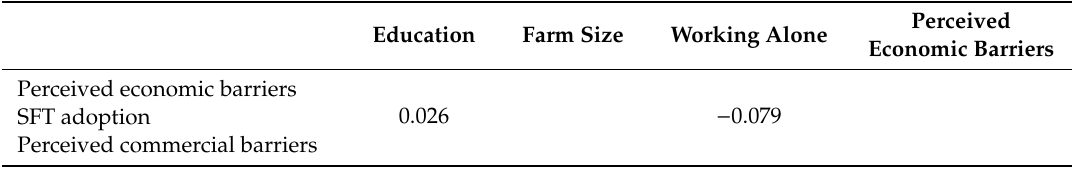
Table 2. Indirect associations of education and working alone with SFT